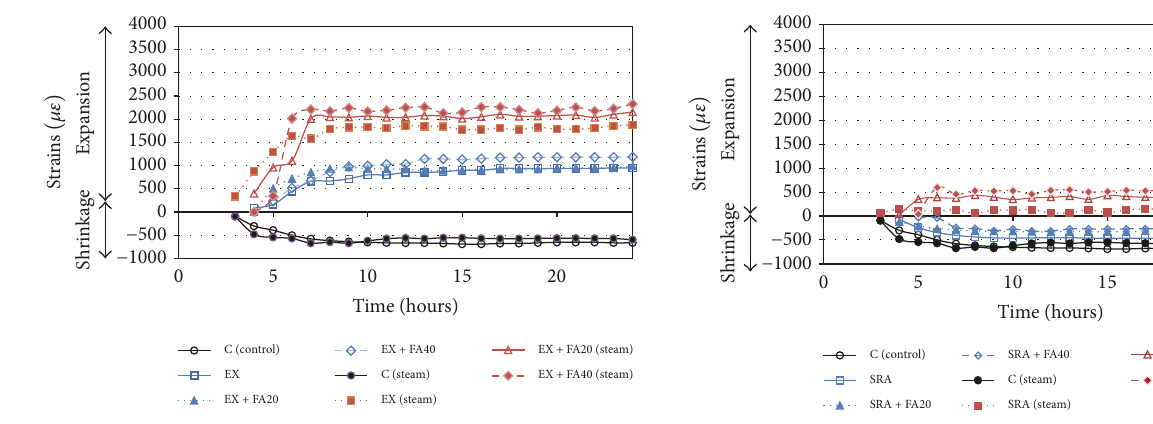
Figure 10: Early age plastic shrinkage results for SRA and SRA +